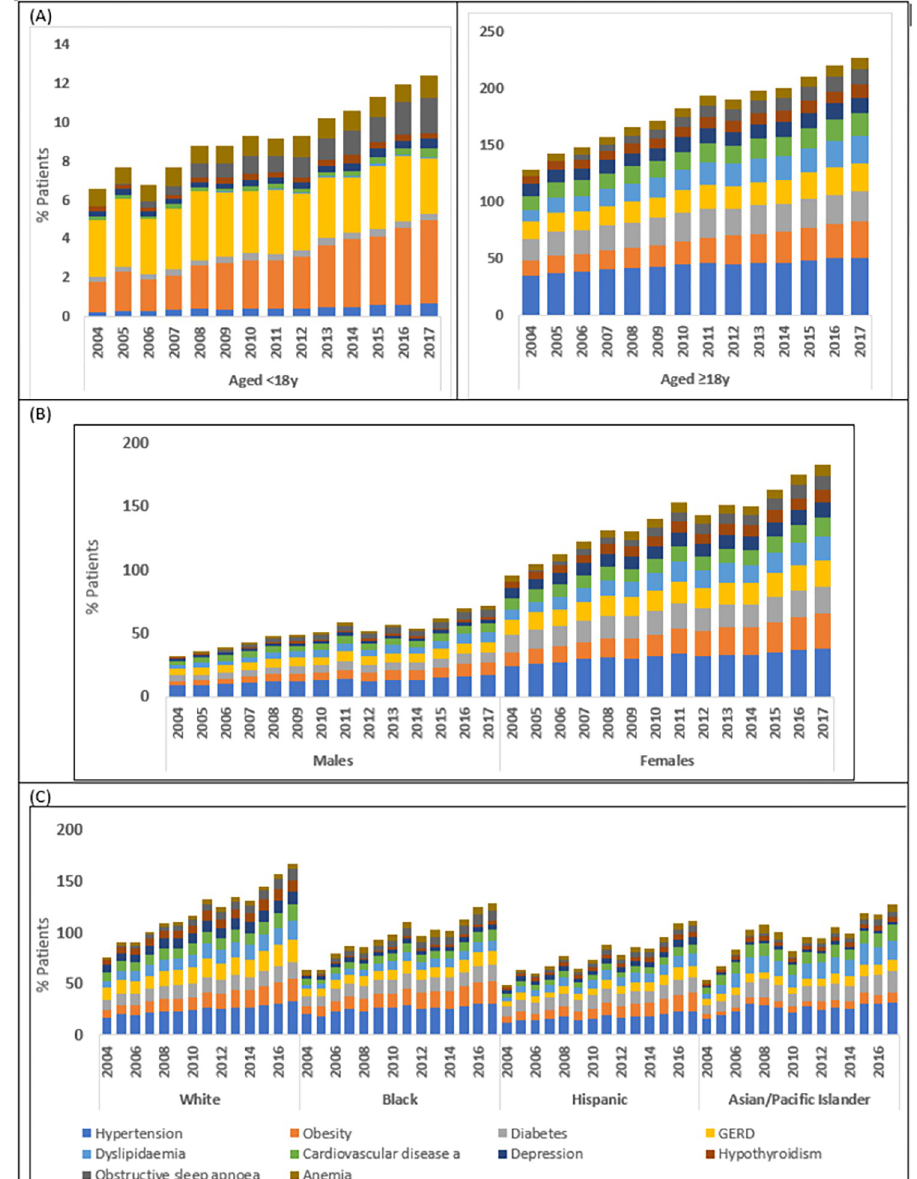
Fig 2. Annual weighted trends of comorbidities by (A) age, (B) sex, and (C) race in patients admitted with asthma between 2004 and 2017. GERD: gastroesophageal reflux disease. admissions started to decline from 2013, whilst ventilator use and in-hospital-deaths increased. Mean age increased over time and most admitted patients were females. Hypertension, obe- sity, diabetes, GERD, and CVD were the most prevalent comorbidities, while anemia was more prevalent in younger patients. Over time, the prevalence of mental illness increased by Older patients, with GERD, OSA, or psychoses had longer stays. Despite these changes in demographics towards a more comorbid phenotype, LOS remained unchanged although costs doubled even after inflation-adjustment.